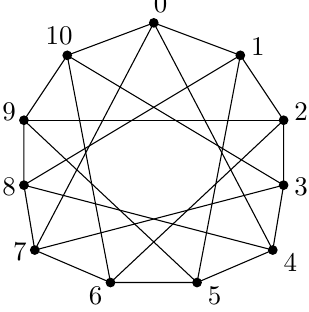
Figure 1: The Andr´asfai graph And (4)